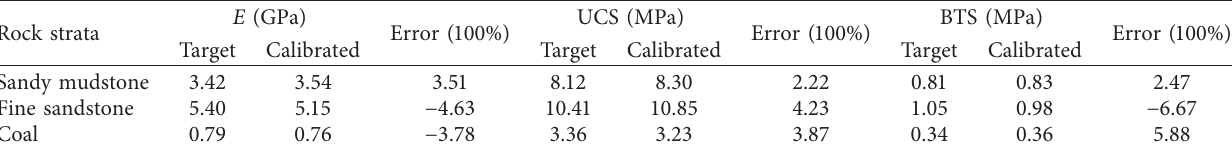
Table 3: Comparison of theoretical and simulated values of elastic modulus, compressive strength, and tensile strength of rock mass. Rock